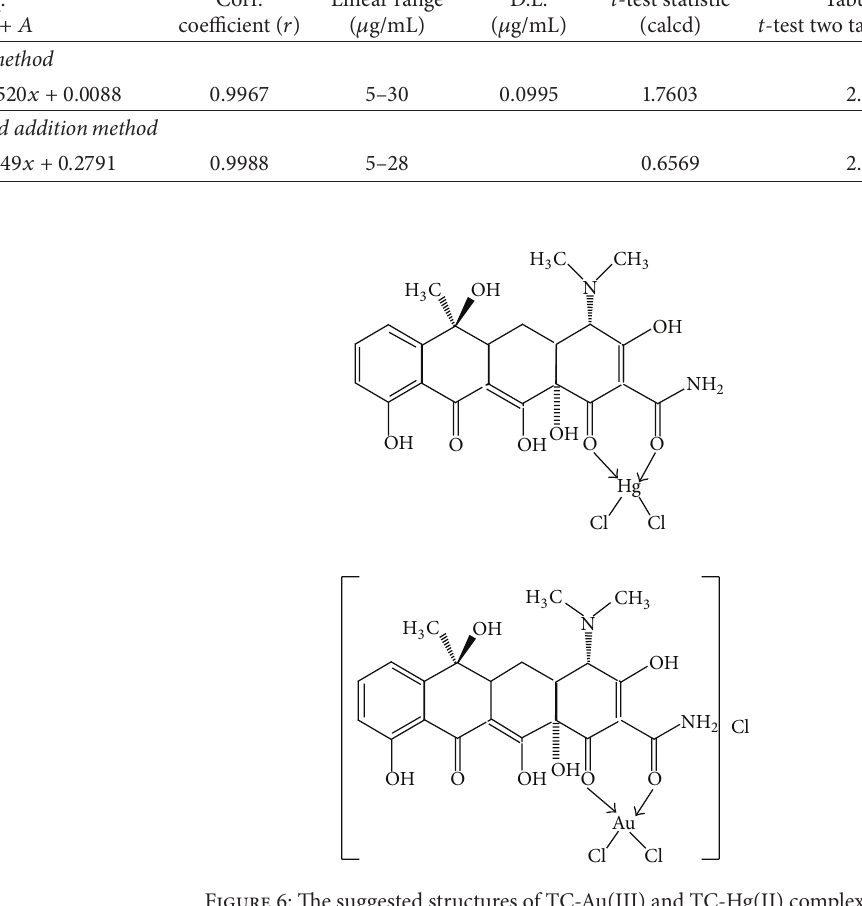
Figure 6: The suggested structures of TC-Au(III) and TC-Hg(II)